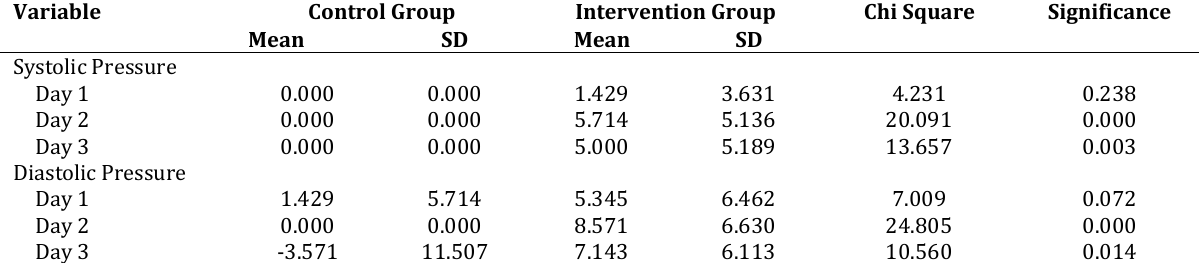
Table 1. Data Analysis Using One-Way ANOVA